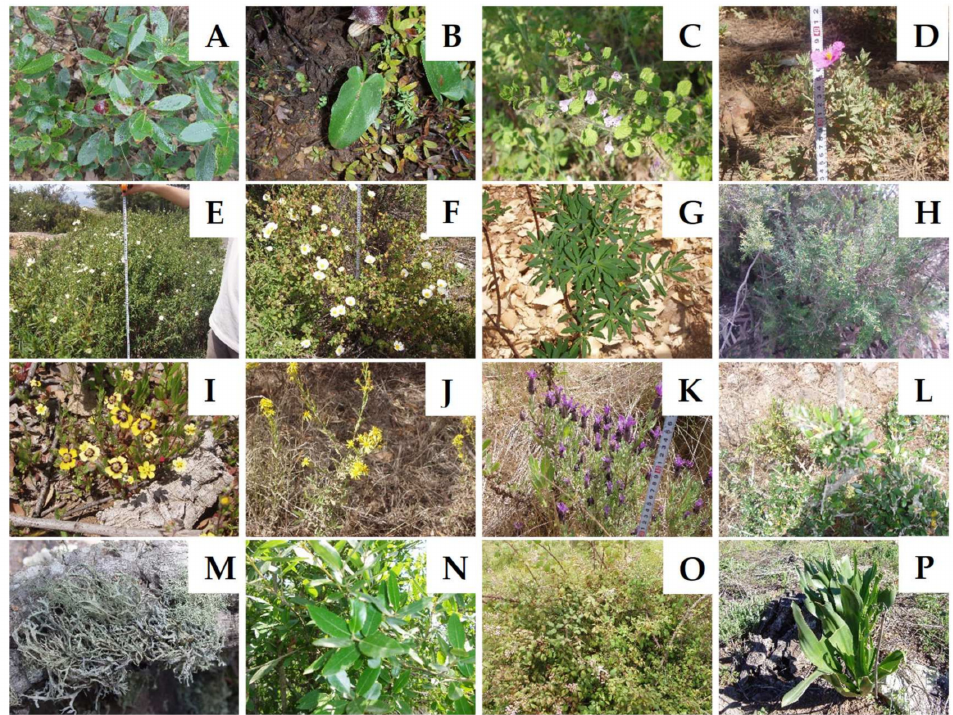
Figure 8. Palatability degree of some flora recorded in the Southern Mediterranean forest rangelands of Northern Morocco. ( A ) Arbutus unedo (palatable); ( B ) Arisarum simorrhinum Durieu (non-palatable); ( C ) Clinopodium nepeta (palatable); ( D ) Cistus crispus (highly palatable); ( E ) Cistus monspeliensis (highly palatable); ( F ) Cistus salviifolius (highly palatable); ( G ) Daphne gnidium L. (non-palatable); ( H ) Erica arborea (palatable); ( I ) Tuberaria guttata (L.) Fourr. (moderate preference); ( J ) Inula viscosa (L.) Greuter, (palatable); ( K ) Lavandula stoechas (palatable); ( L ) Olea europea var. sylvestris (palat- able); ( M ) Parmelia physodes (moderate preference, Lichen); ( N ) Phillyrea latifolia (highly palatable); ( O ) Rubus ulmifolius (palatable); ( P ) Drimia maritima (L.) Stearn (non-palatable) (Photos by